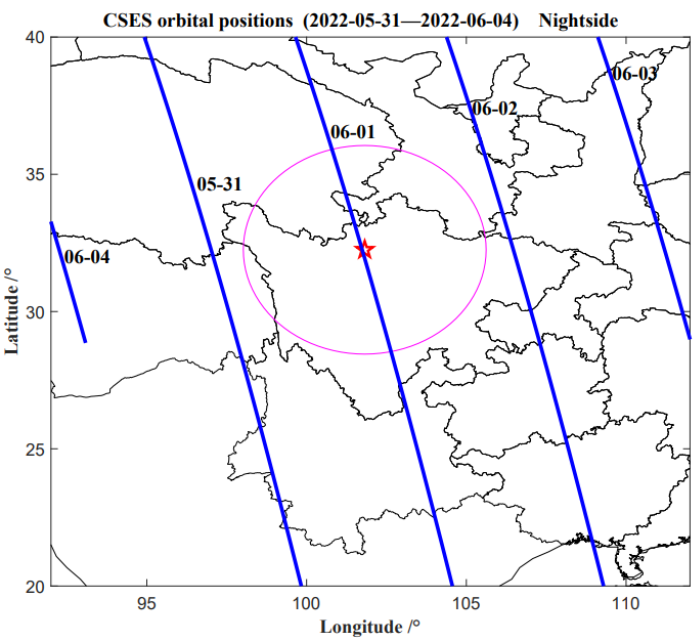
Figure 6. CSES orbital positions in the study area from 31 May to 4 June. The blue line represents the orbit of CSES in the nighttime, the red star represents the epicenter, the red circle shows the seismogenic zones (approximately 380 km in radius).